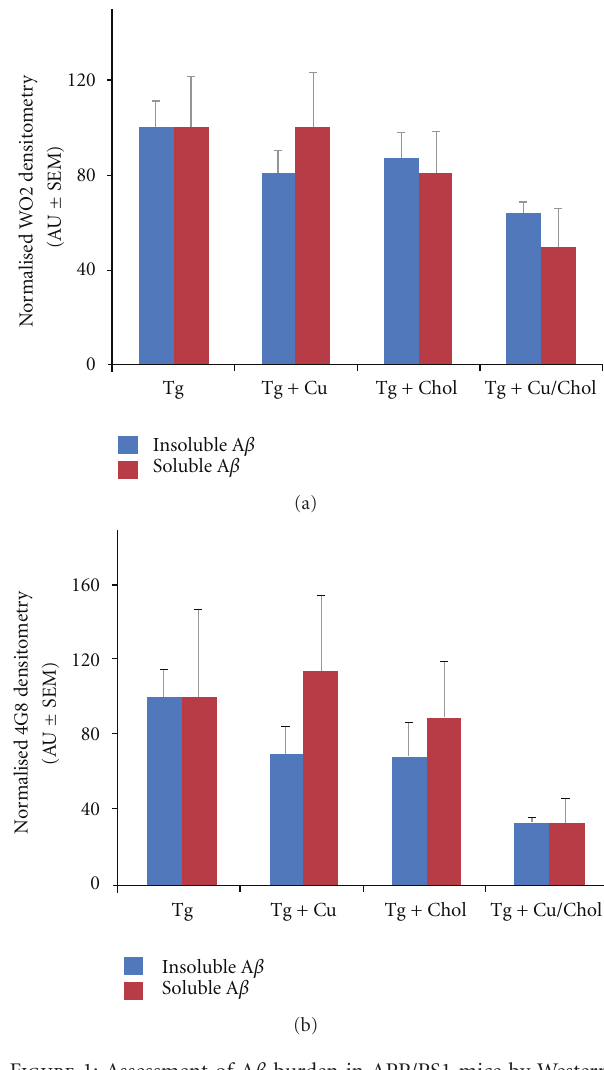
Figure 1: Assessment of A β burden in APP/PS1 mice by Western blot. Total hemisphere homogenates (sonicated in PBS followed by centrifugation at 100,000 × g for 30 minutes at 4 ◦ C and subsequent isolation of the soluble and insoluble fractions. The insoluble fraction was resuspended in PBS prior to a BCA assay and subsequent Western blot) were assessed for A β content using both an in-house antibody (WO2) (a) and a commercial (4G8) (b) antibody. A significant reduction in insoluble A β was seen with both antibodies for the combined high copper and cholesterol treatment group only, as compared to the Tg control group